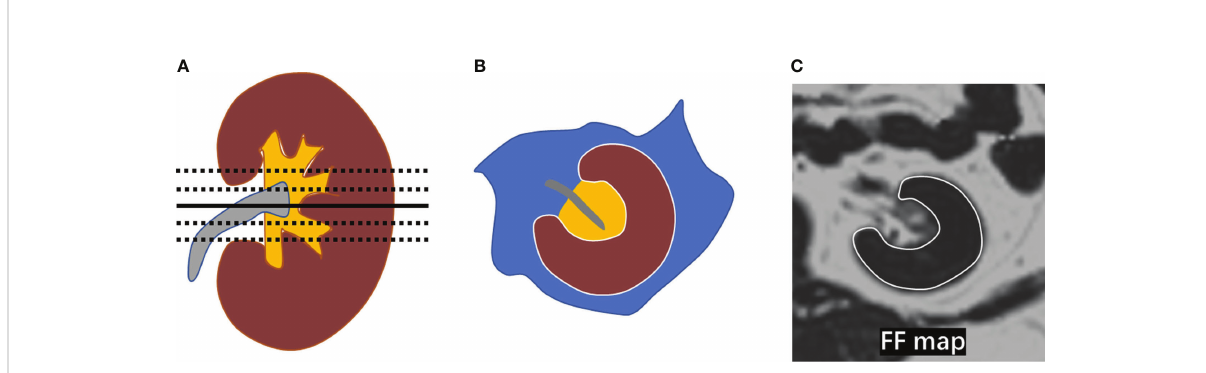
FIGURE 2 Measurement of renal FF. (A) The fi ve levels (black line) centered on the renal hilum (black solid line) were selected in the kidney; (B) A diagram depicting the placement of a region of interest (ROI) in the entire renal parenchyma (brown area) with the boundary marked by a white line; (C) ROIs were manually placed on the fi ve selected levels in the FF map avoiding the perirenal fat and renal sinus fat